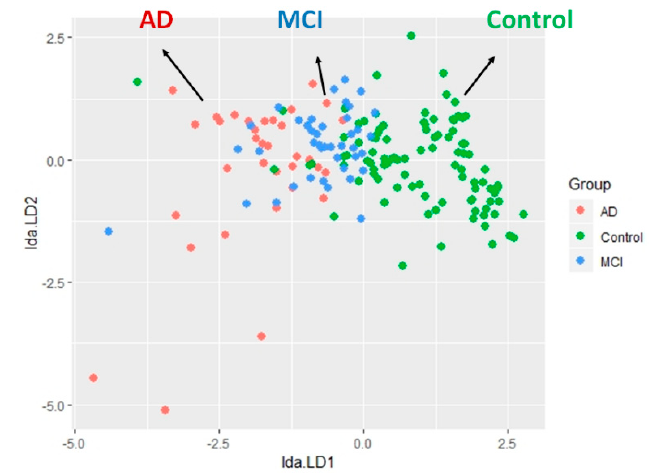
Figure 5. The 2D scatter plot demonstrates that LDA separated sample points of the AD spectrum.